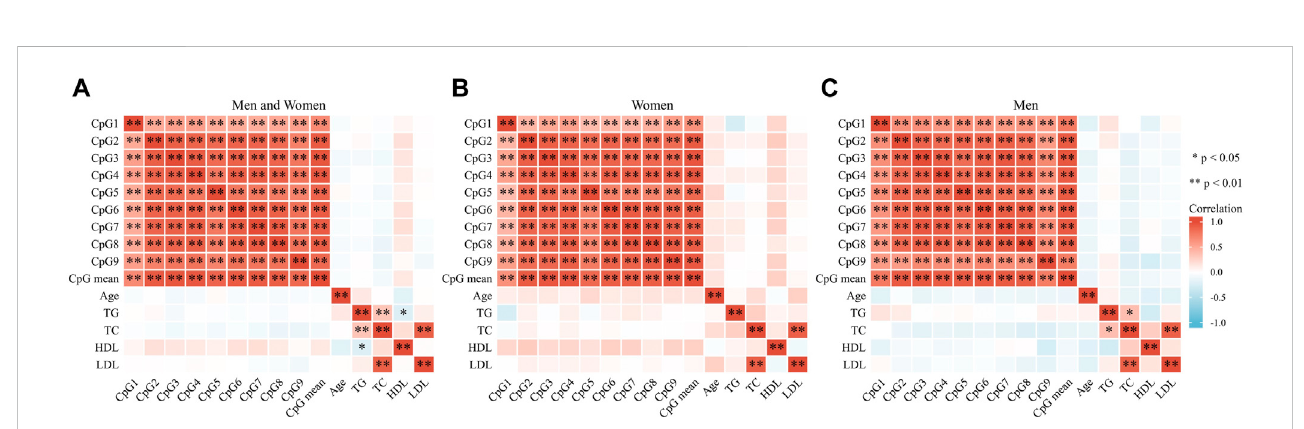
FIGURE 2 Pearson correlation analysis involving GSTA4 methylation status and clinical characters. (A) Inmen and women: methylation levels ofall nine CpGs were signi fi cantly correlated. (B) In men: methylation levels of all nine CpGs were signi fi cantly correlated. (C) In women: methylation levels of all nine CpGs were signi fi cantly